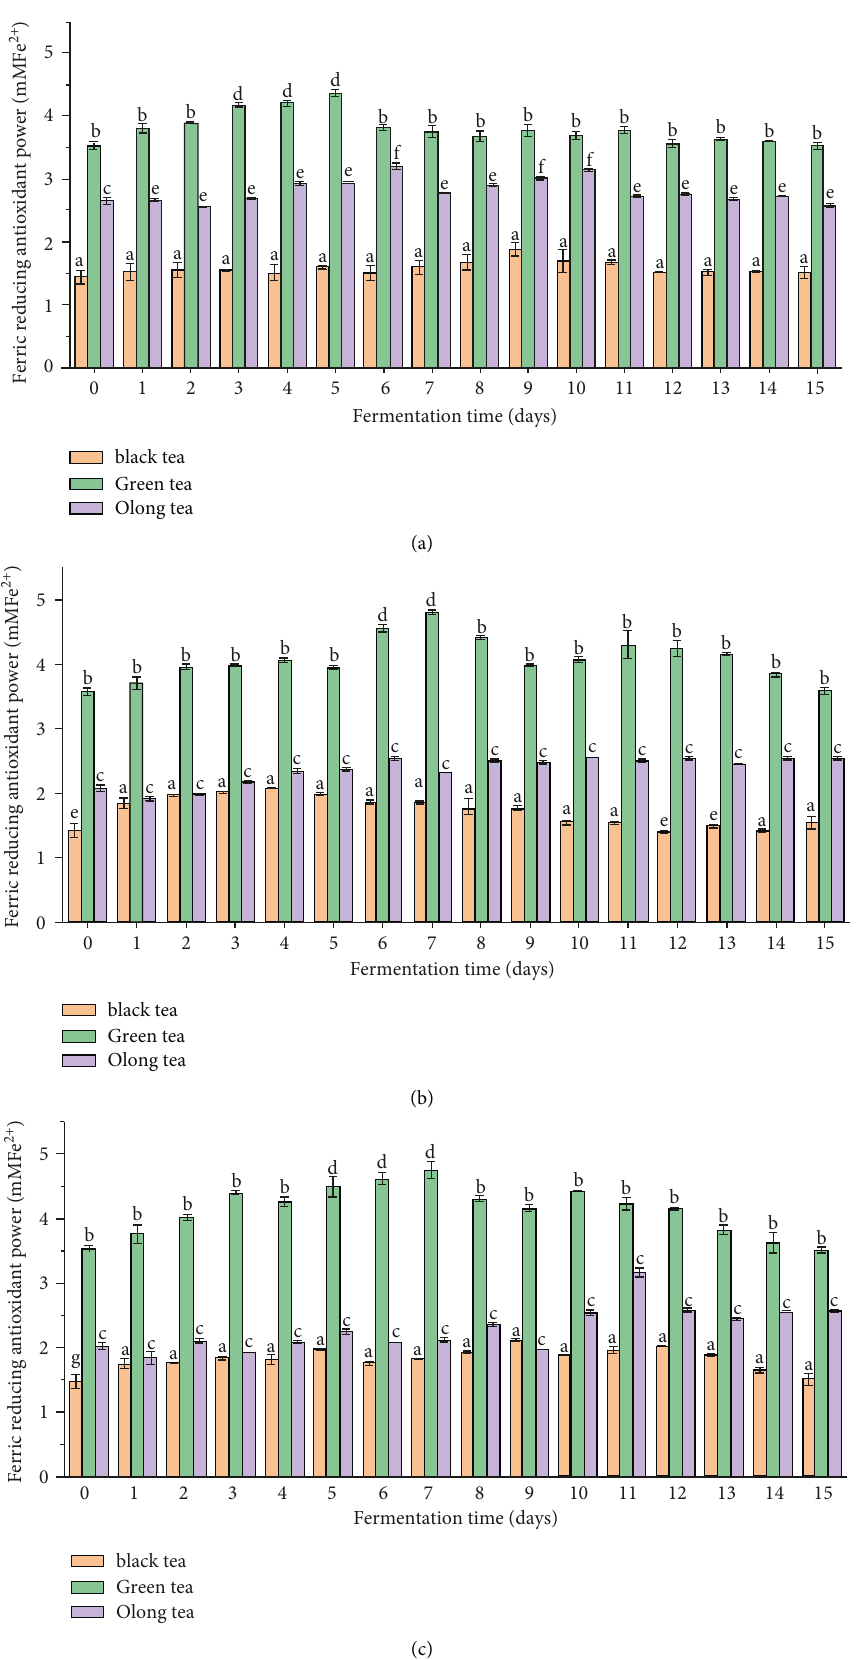
Figure 1: Changes in antioxidative activity of kombucha fermented from three different teas at different temperatures ((a) 35 ° C; (b) 30 ° C; (c) 25 ° C) measured by ferric reducing antioxidant power. Different letters in the same graph indicate significant difference ( P < 0 .